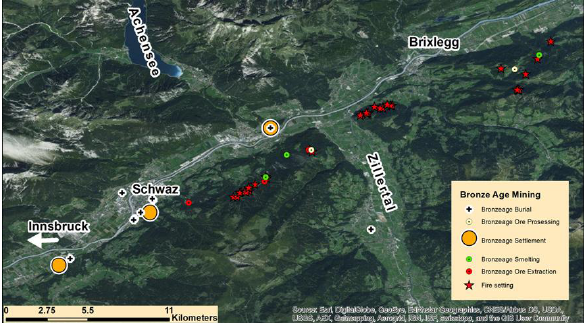
Figure 10. Map of known bronze age sites related to mining, settlement and burial activities together with sites where fire setting technology was